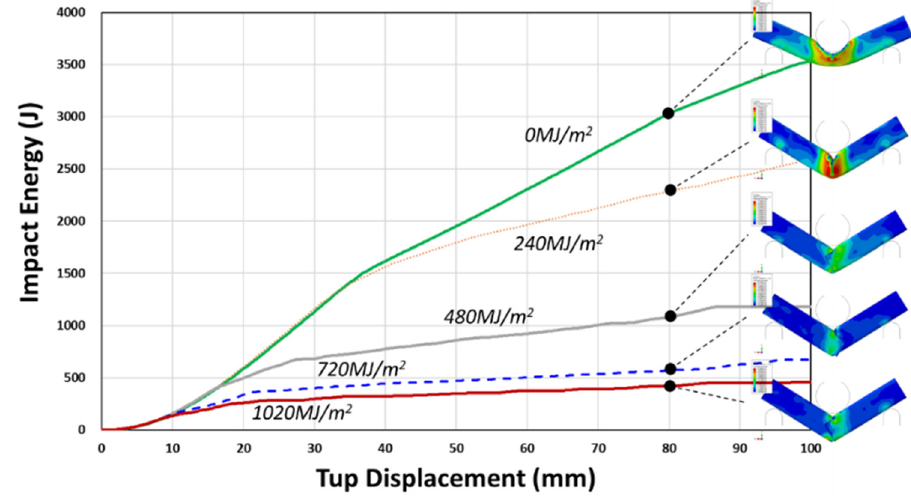
Figure 21. Impact energy versus tup displacement curves of 3-point bending impact analysis for weather-induced PC channel section.